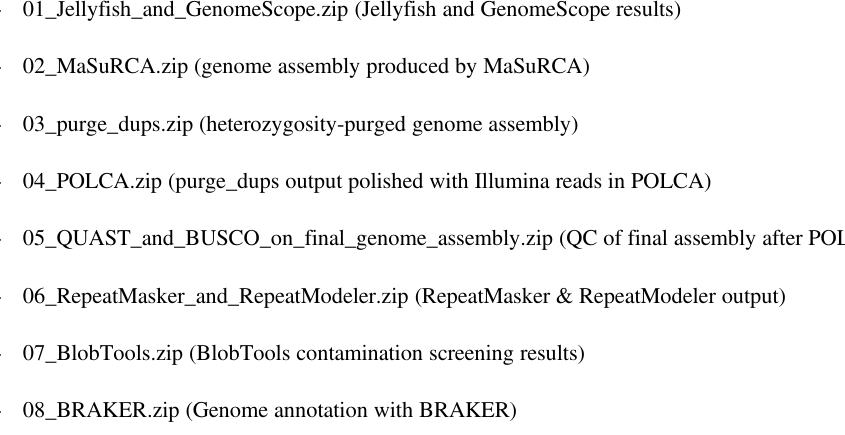
Figshare: Hanleya hanleyi genome extended data. https://doi.org/10.6084/m9.figshare.19672449.v2 (Kocot 2022). This project contains the following extended